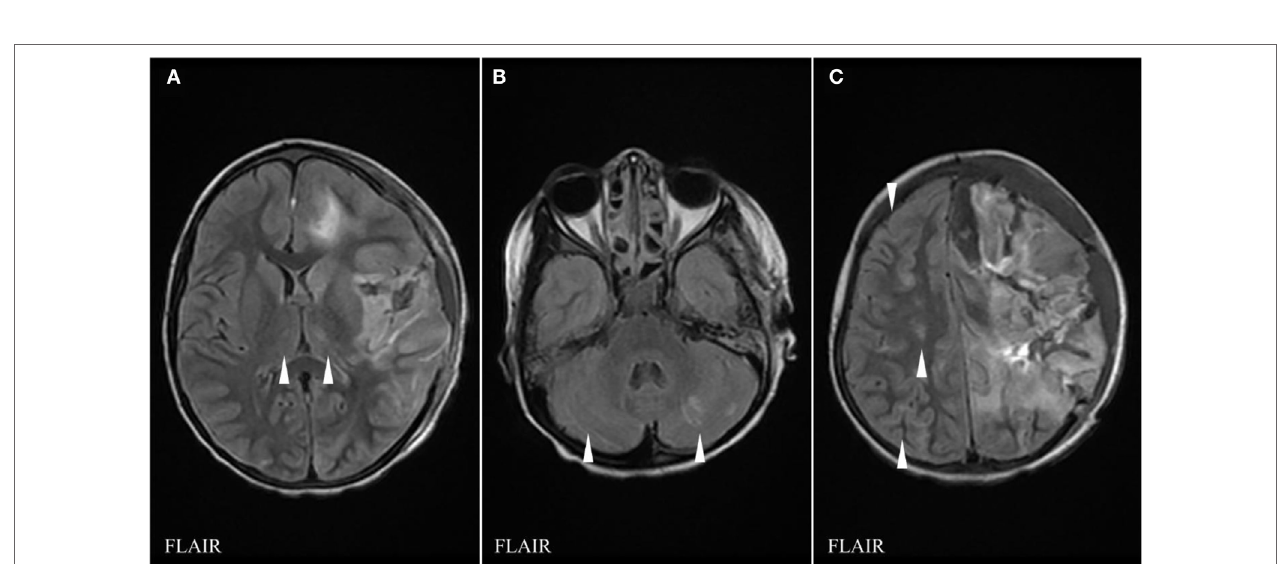
FIguRe 2 | Brain magnetic resonance imaging (MRI) (day 30) at the time of the relapse of the neurological manifestations showing left frontoparietal cortical and subcortical areas of isointense T1, high T2 (a) , FLAIR (B) , and restricted diffusion (C) signals (arrowhead) increasing in size along the MRI examination, due to an active hyperacute bleed [arrow (a) pointing at spot sign indicating active bleed]. Area of high T2 and FLAIR signal changes (arrowheads) in the head of the caudate nucleus (D) and of abnormal diffusion weighed images (DWI) in the subcortical right cerebellar white matter (arrowheads) (e) . Previous left midbrain lesion has resolved with only a tiny residual of high FLAIR signal corresponding to minimal residual gliosis (arrowhead) (F) . Follow-up brain MRI at D33 showing a necrotico- hemorrhagic lesion in the left hemisphere (g,I) , interval evolution of cortical/subcortical lesions, with new lesions in the bilateral thalami (g) , cerebellar hemispheres (H) , and right cerebral hemisphere (I) (arrowheads indicate abnormal